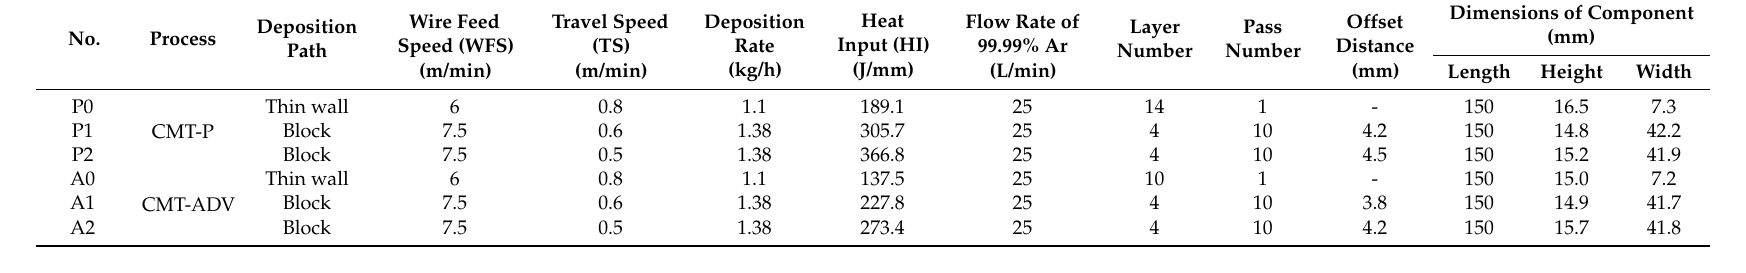
Table 2. The parameters of the depositing process and dimensions of the components.